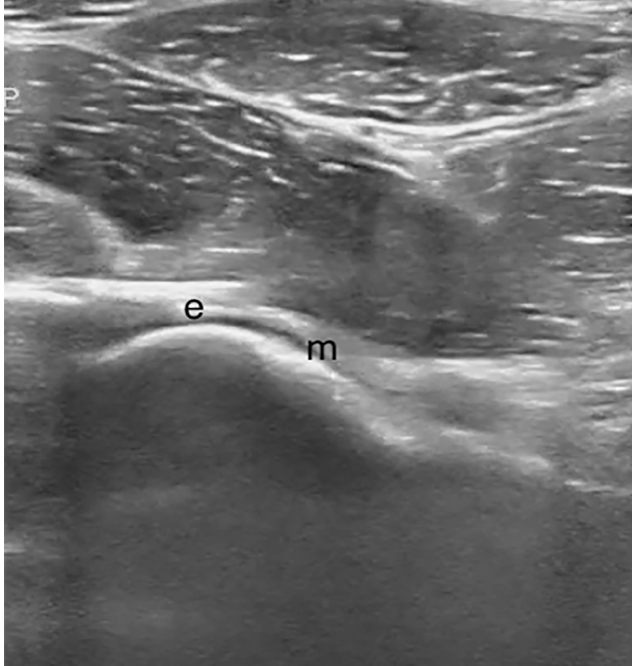
Image 2. Point-of-care ultrasound image of right hip showing normal contour of metaphysis (m) and epiphysis (e) with no